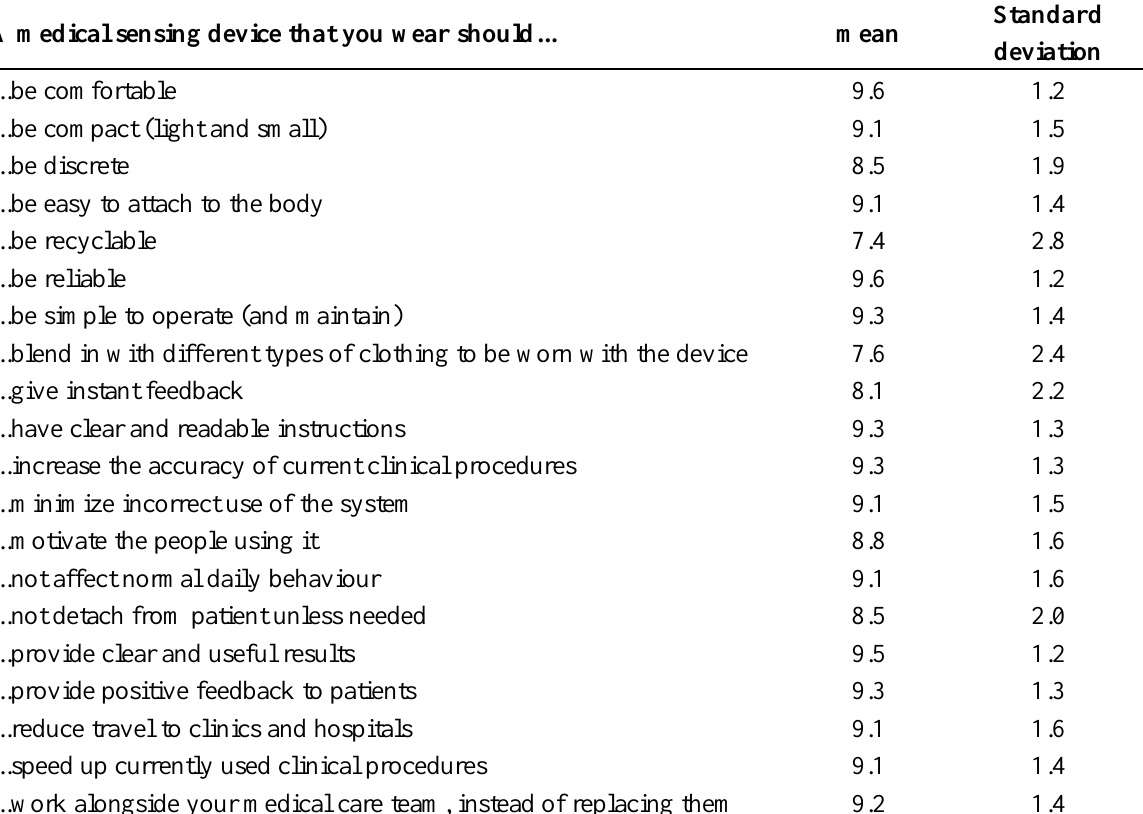
Table 4. Percentage of responders providing a response on a 10-point Likert scale to the questions that relate to the measuring system. Participants were asked on a scale of 1 to 10 how important the following statements were, with 10 being the